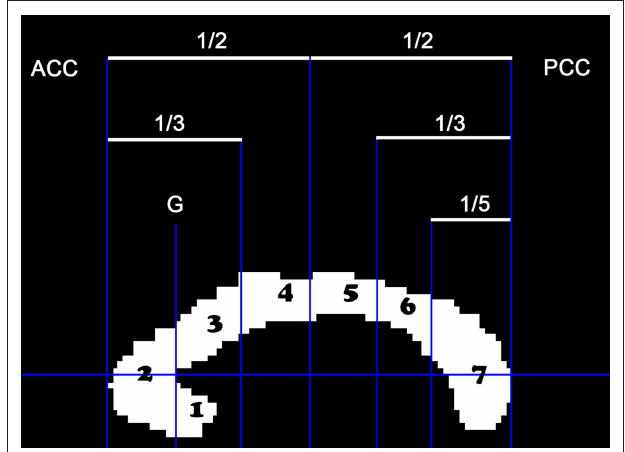
FIguRe 2 | The cross-sectional area of the mid-sagittal CC was parsed into seven regions: (1) rostrum, (2) genu, (3) rostral truncus, (4) anterior intermediate truncus, (5) posterior intermediate truncus, (6) isthmus, (7) splenium.